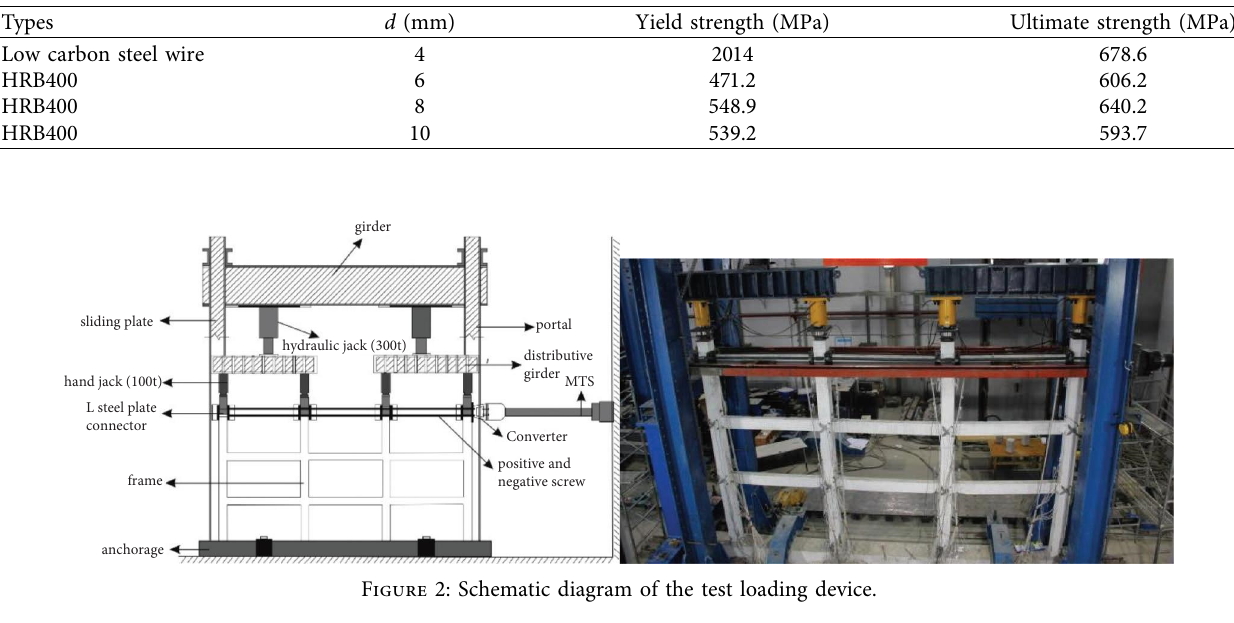
Table 2: Properties of reinforcements.